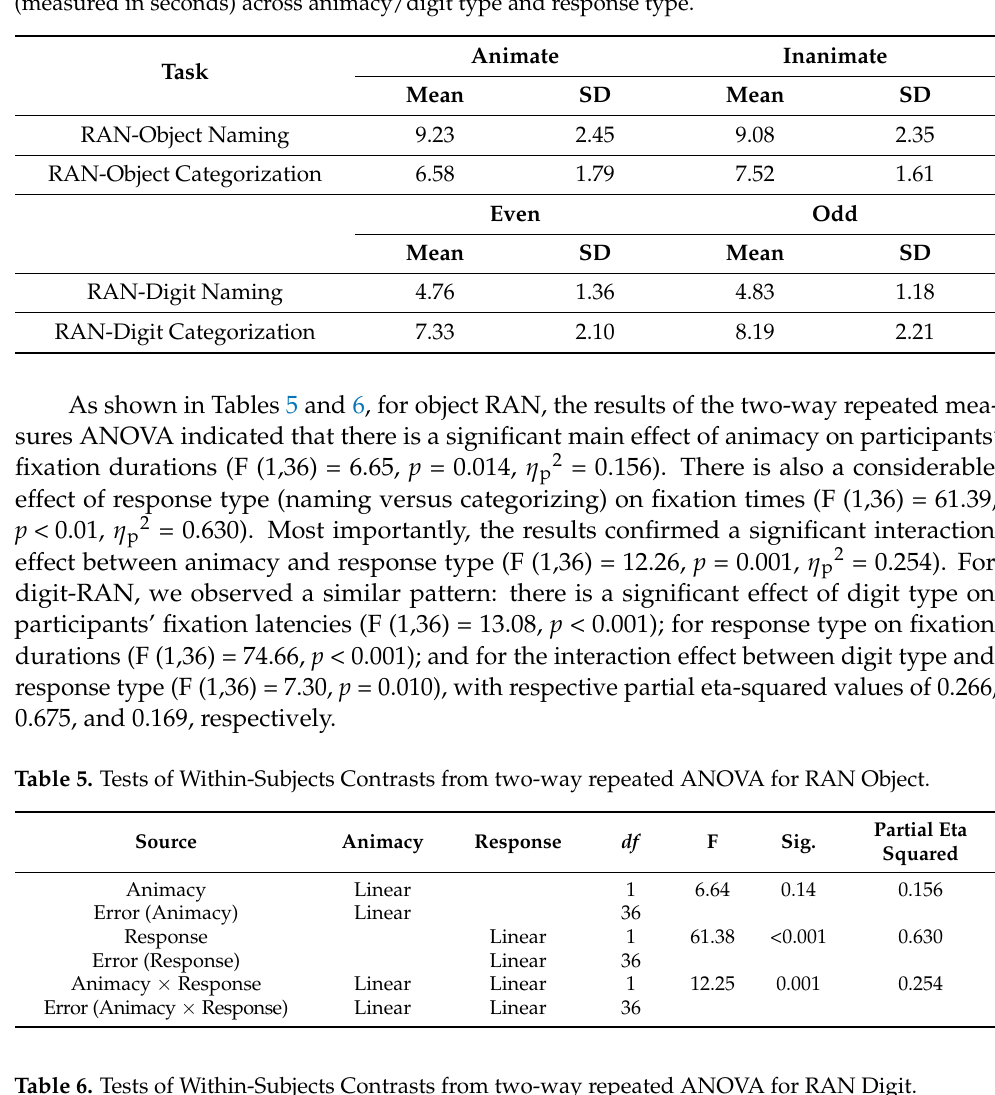
Table 6. Tests of Within-Subjects Contrasts from two-way repeated ANOVA for RAN Digit.